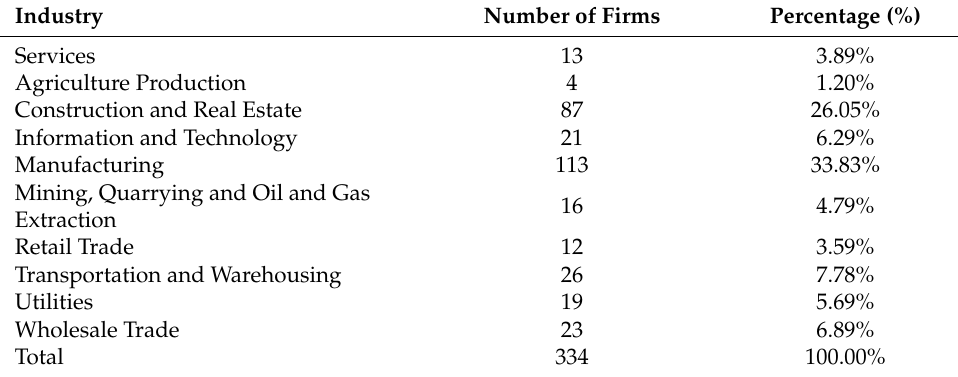
Table 1. Description of